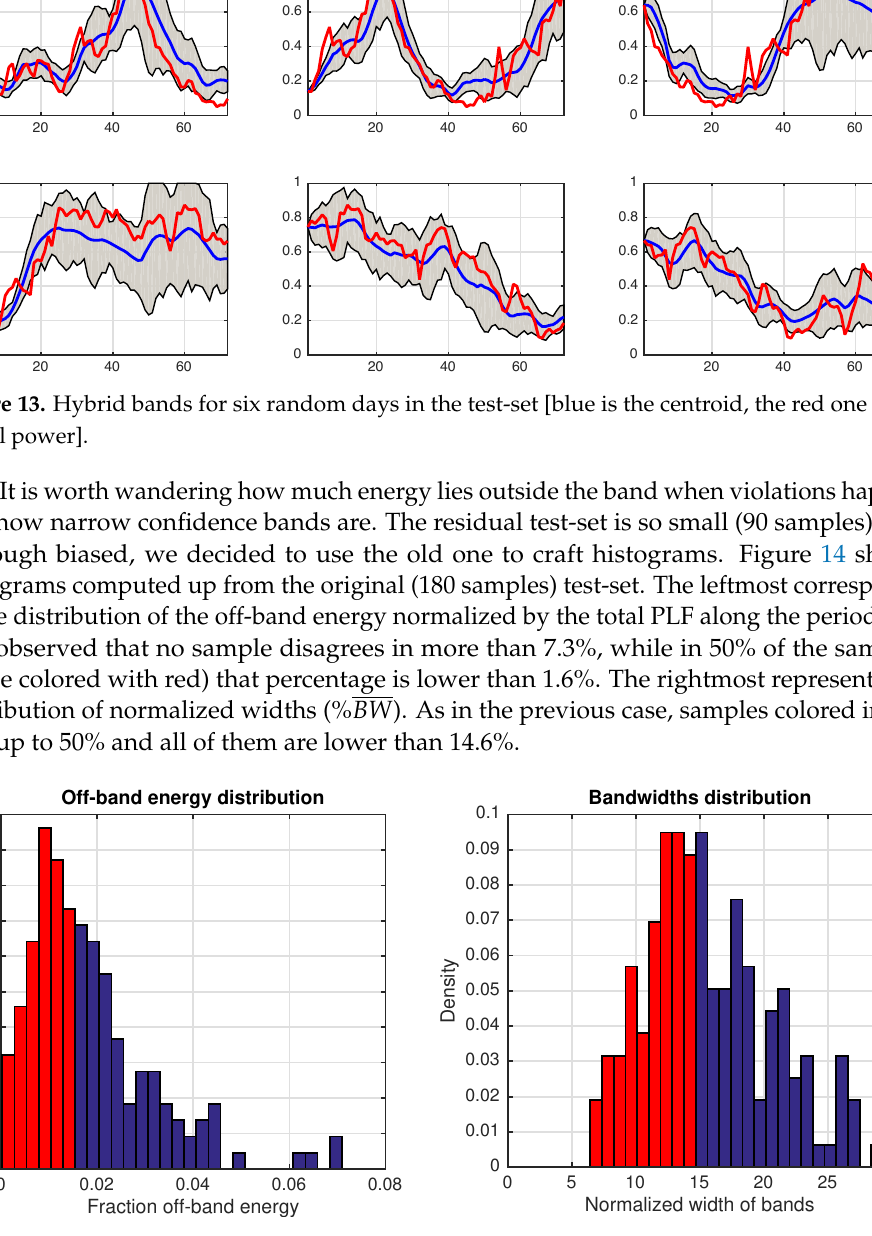
Figure 14. Histograms for relative off-band energy and widths of the